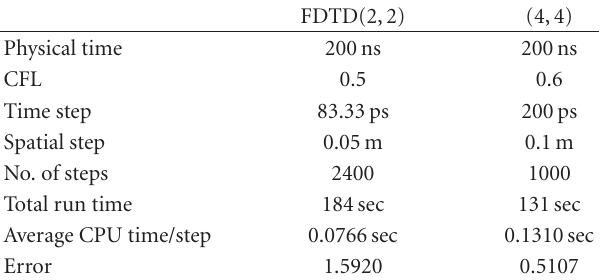
Table 2: Comparison of results for FDTD(2, 2) and (4,